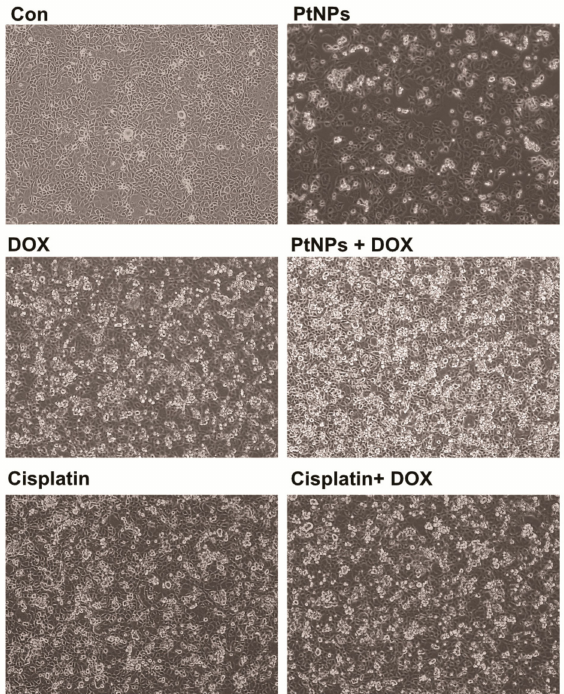
Figure 7. PtNPs and DOX alter U2OS cell morphology. The e ff ect of PtNPs and DOX on cell morphology was determined using an optical microscope after exposure to PtNPs (10 µ g / mL), DOX (1 µ g / mL), CIS (5 µ g / mL), or a combination of PtNPs (10 µ g / mL) and DOX (1 µ g / mL) or combination of DOX (1 µ g / mL) and CIS (5 µ g / mL) for 24 h. Results are expressed as the mean ± standard deviation of three independent experiments; at least three independent experiments were performed for each sample. Cells exposed to PtNPs and DOX had lost their typical shape and cell adhesion capacity and reduced in size and cell density. Scale bar: 200 µ